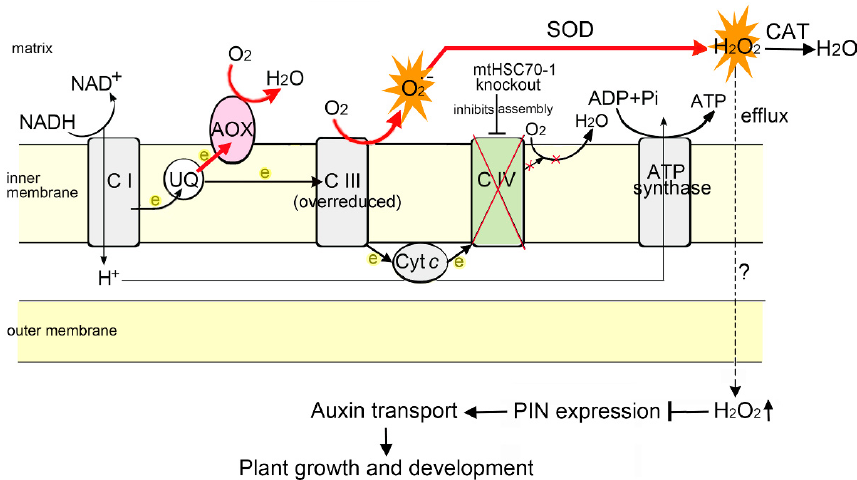
Figure 11. A working model for the function of mtHSC70-1 in the regulation of Arabidopsis growth and development. mtHSC70-1, as a molecular chaperone, assists in complex IV/cytochrome c oxidase (COX) assembly. The loss of mtHSC70-1 function inhibits the assembly/activity of COX, which results in the malfunction of the cytochrome respiratory pathway, which leads to the excessive production of ROS at the site of over-reduced complex III, and the activation of the alternative respiratory pathway. The high levels of ROS in mtHSC70-1 mutants interfere with polar auxin transport, subsequently impacting the growth and development of plants. Inhibited and increased pathways are indicated with black lines and red lines, respectively. The bars show blockage effects. Black dashed line indicates an unproven route. Complex IV and electron transfer disruption is shown with red crosses. CI, CIII and CIV, respiratory chain complexes I, III and IV; AOX, alternative oxidase; UQ, ubiquinone; Cyt c , cytochrome c ; SOD, superoxide dismutase; CAT, catalases.